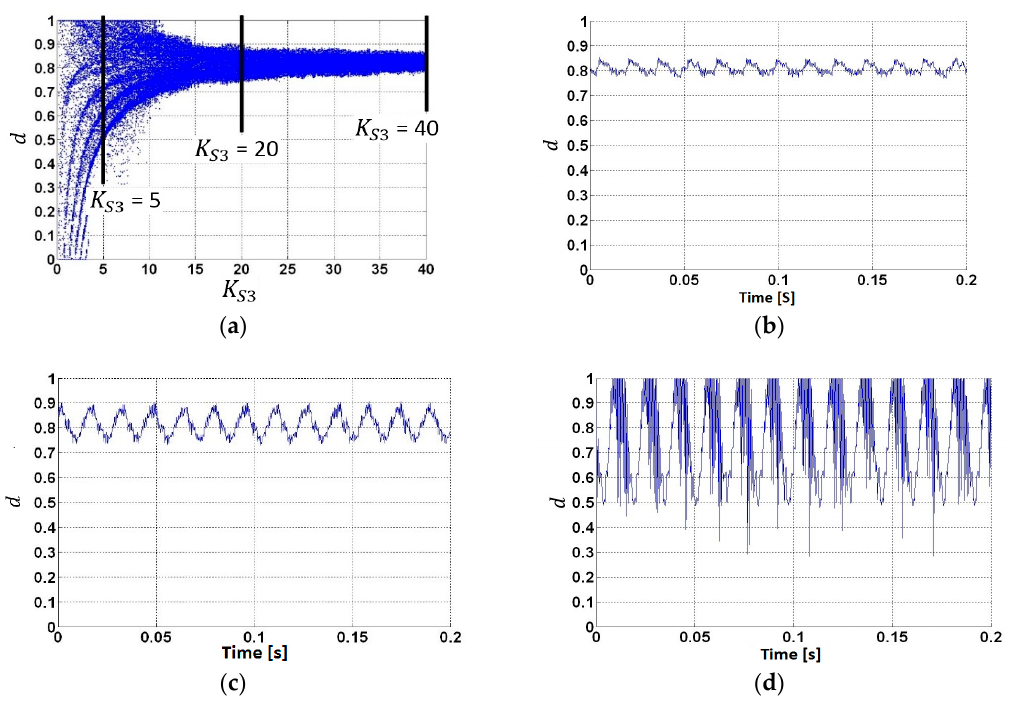
Figure 11. Bifurcation diagram of d vs. K S 3 and behavior of K S 3 = 40, K S 3 = 20, and K S 3 = 5 when the values of K S 1 = K S 2 = 2 and N = 1: ( a ) bifurcation diagram of d vs. K S 3 in the experimental test; ( b ) behavior of d when K S 3 = 40 in the experimental test; ( c ) behavior of d when K S 3 = 20 in the experimental test; and ( d ) behavior of d when K S 3 = 5 in the experimental